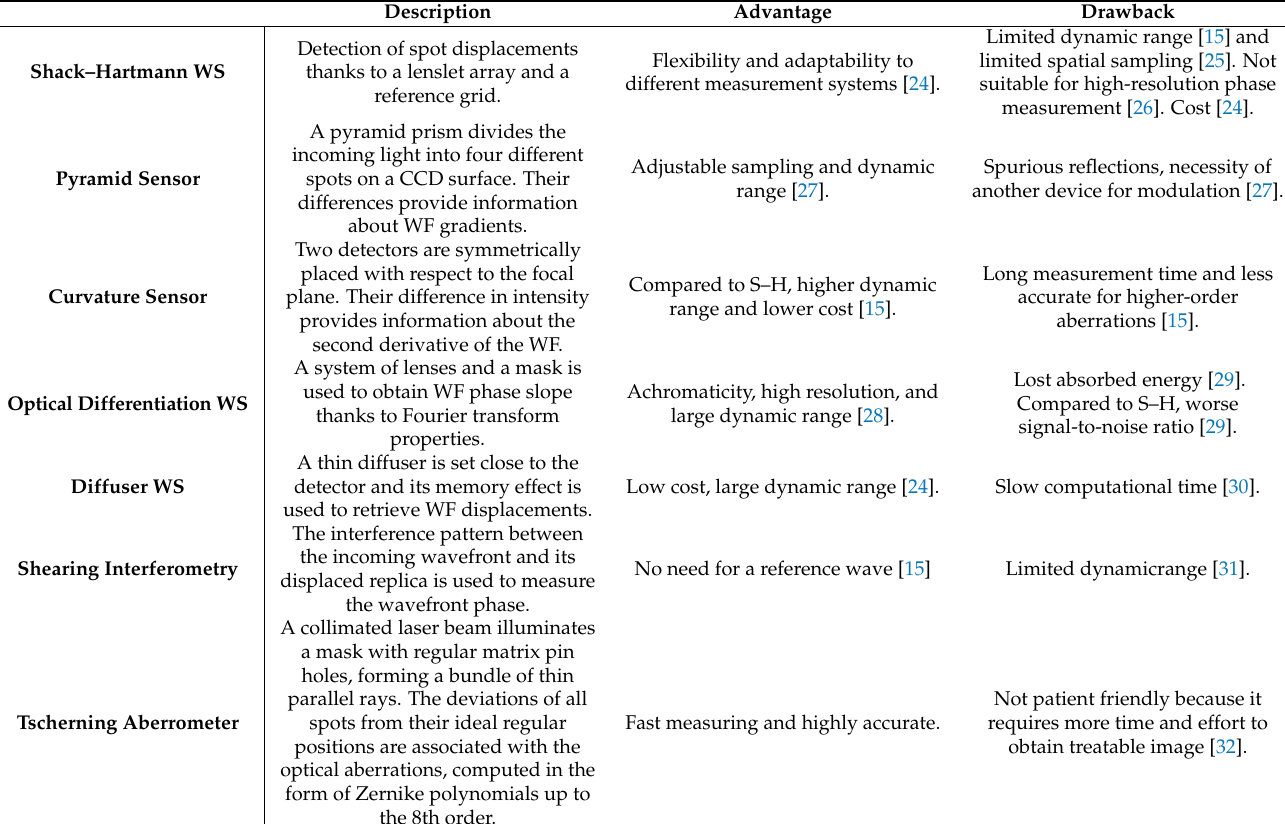
Table 1. Wavefront sensors for ophthalmological